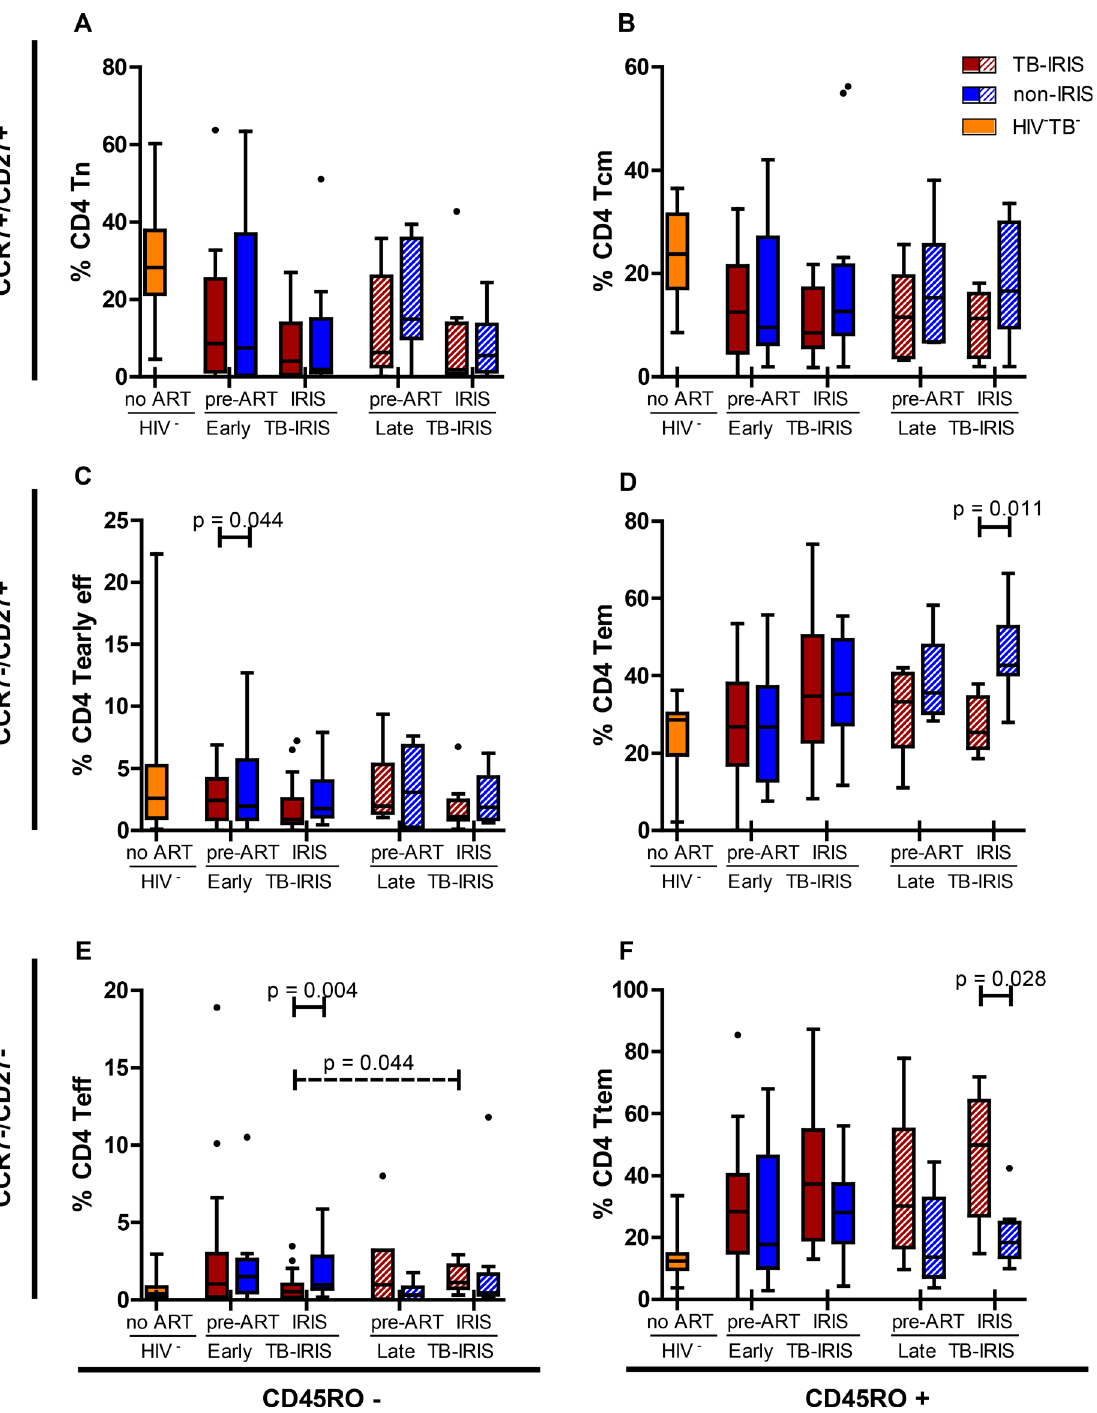
Fig 5. Percentage of CD4+ maturation sub-stages in early-onset TB-IRIS patients. These box and Tukey whisker plots represent median percentages and IQR of; A, na ï ve cells (Tn); B, central memory cells (Tcm); C, early effector cells (Tearly eff); D effector memory cells (Tem); E, effector cells (Teff); F, terminal effector memory cells (Ttem) within CD4+ T cells for early- and late-onset TB-IRIS patients (red) and non-IRIS controls (blue), 16 HIV-TB- (yellow) and 11 HIV-TB+ (green) controls. Full lines above indicate significant differences between paired patients (Wilcoxon signed-rank test). Dashed lines above indicate significant differences between unpaired patient groups (Mann-Whitney U test). The level of significance was set to P < 0.05. Number of patients (and paired non-IRIS controls) prior to ART were; 17 for early-onset TB-IRIS and 6 for late-onset TB-IRIS. Number of patients (and paired non-IRIS controls) during IRIS event or corresponding non-IRIS control time point were; 16 for early-onset TB-IRIS and 9 for late-onset TB-IRIS.